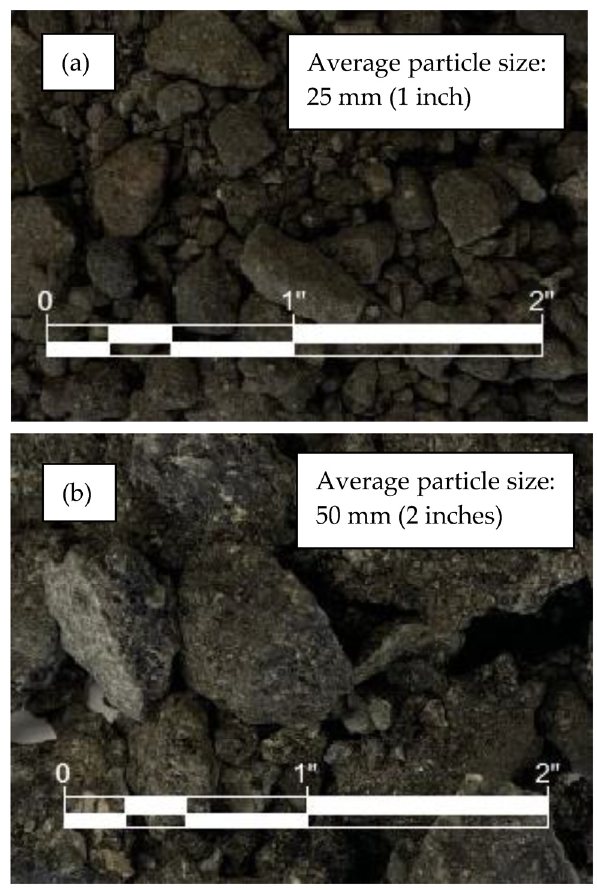
Figure 1. Photographs of: ( a ) processed and ( b ) unprocessed RAP.